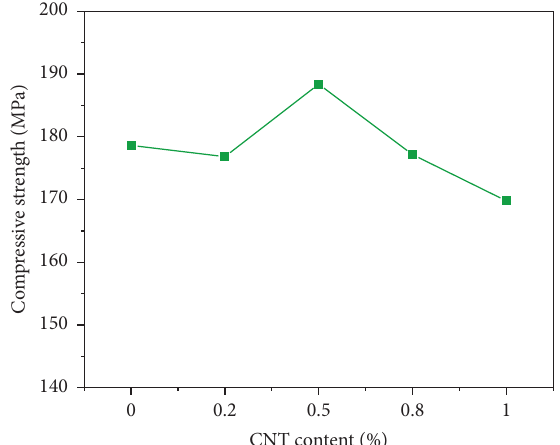
Figure 19: Compressive strength of the UHPC-CNT composites